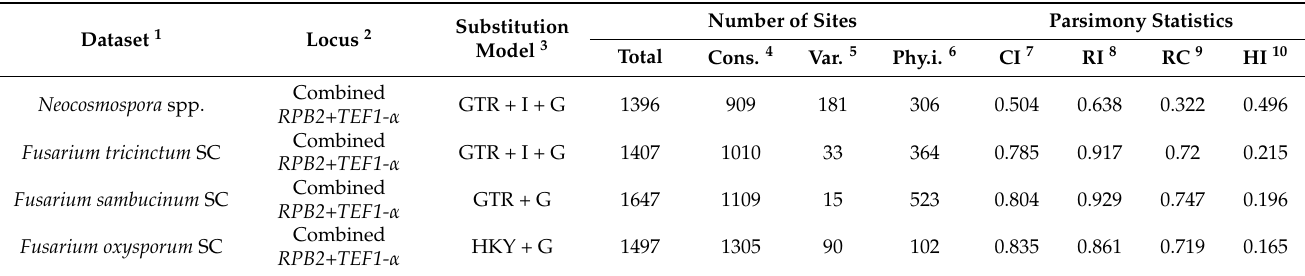
Table 2. Characteristics of the gene partitions used in this